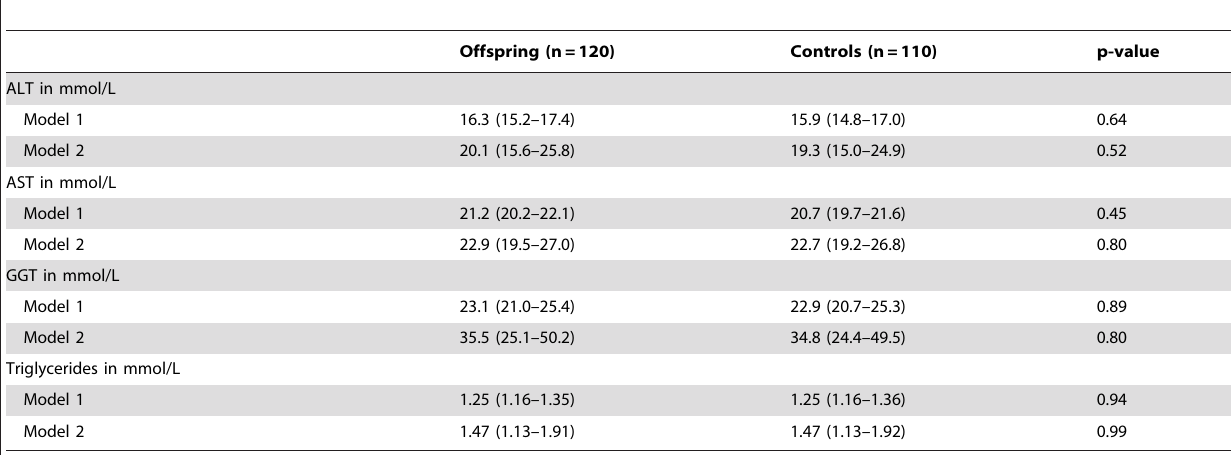
Table 3. Fasting liver enzymes and triglycerides in offspring of long-lived siblings and control subjects.